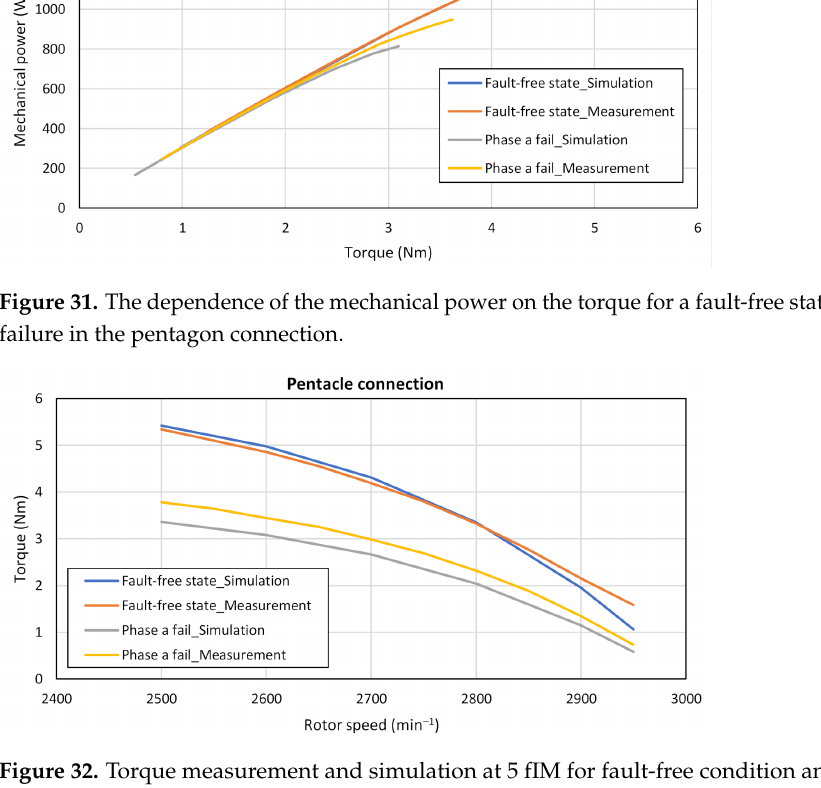
Figure 32. Torque measurement and simulation at 5 fIM for fault-free condition and failure of one phase in pentacle